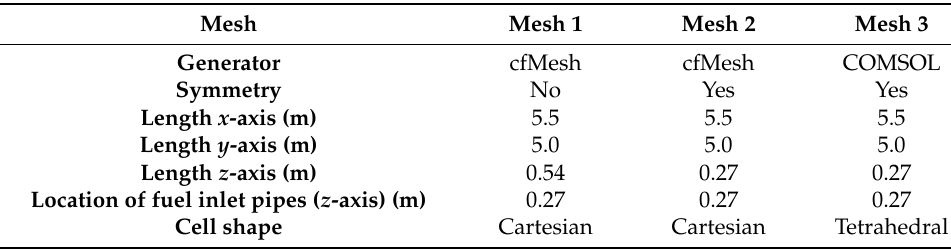
Table 3. Description of 3D geometry and the three